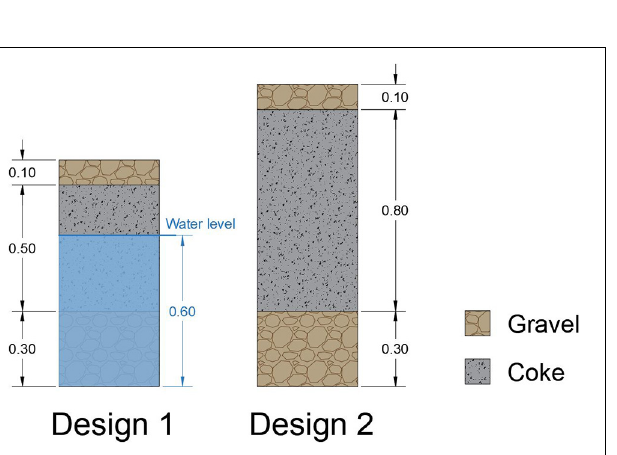
International Reference Life Cycle Data System (ILCD) technical guidance (JCR,